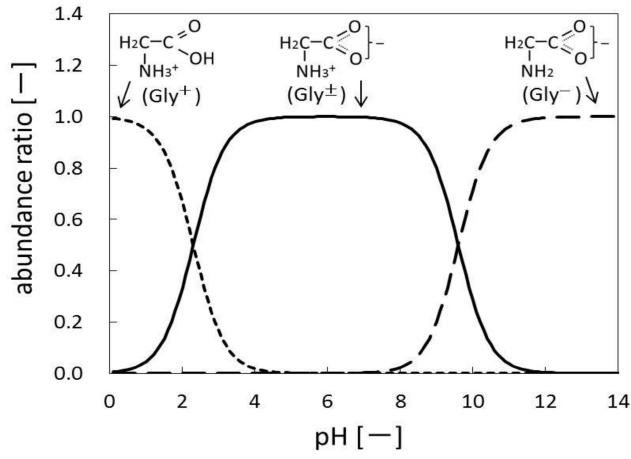
Figure 8. Abundance ratios of Gly + , Gly ± , and Gly – ions as a function of the pH.